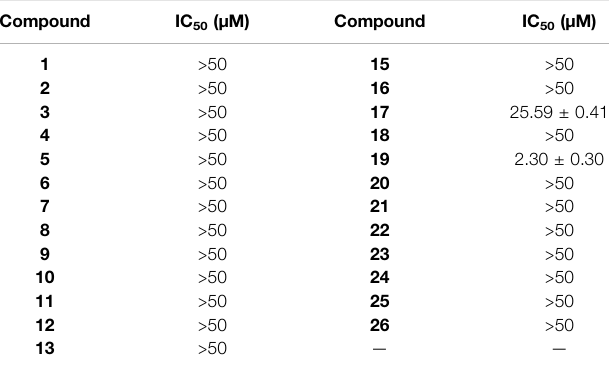
TABLE 3 | Anti-proliferative activity of compounds 1 – 13 and 15 – 26 against HepG2 cells.